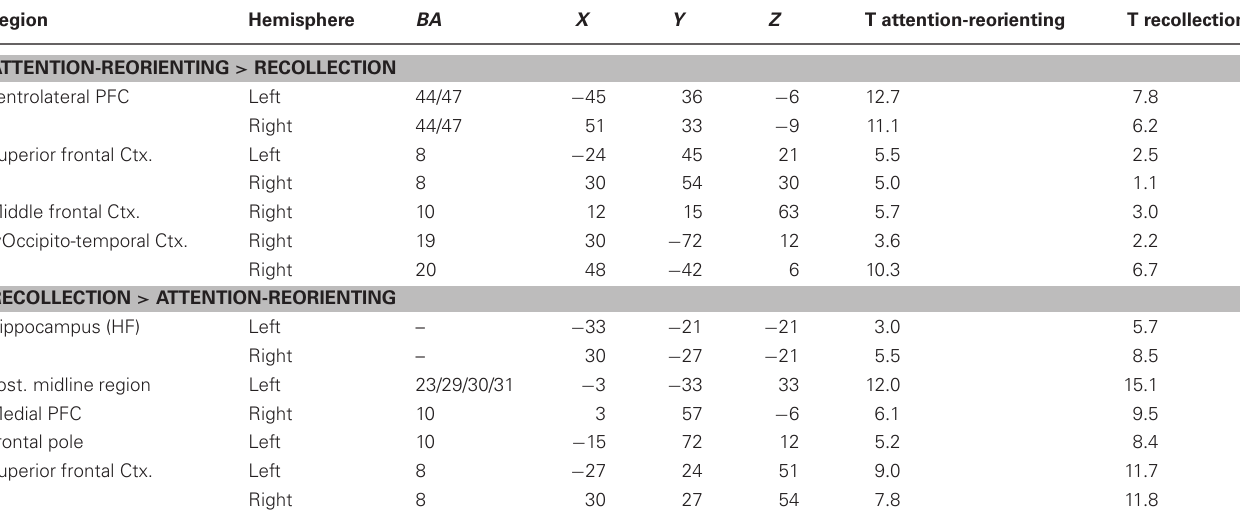
Table 1 | Differences in connectivity between attention-reorienting and recollection seeds. Region Hemisphere BA T attention-reorienting ATTENTION-REORIENTING > RECOLLECTION Ventrolateral PFC Left Superior frontal Ctx. Right Middle frontal